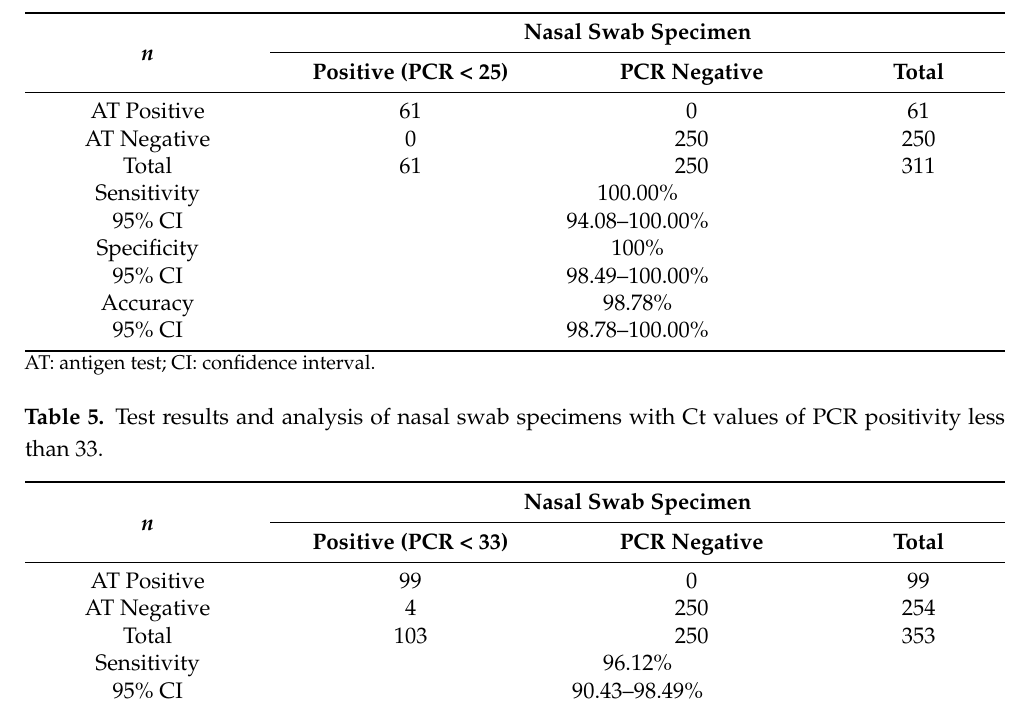
Table 4. Test results and analysis of nasal swab specimens with Ct values of PCR positivity less than 25.